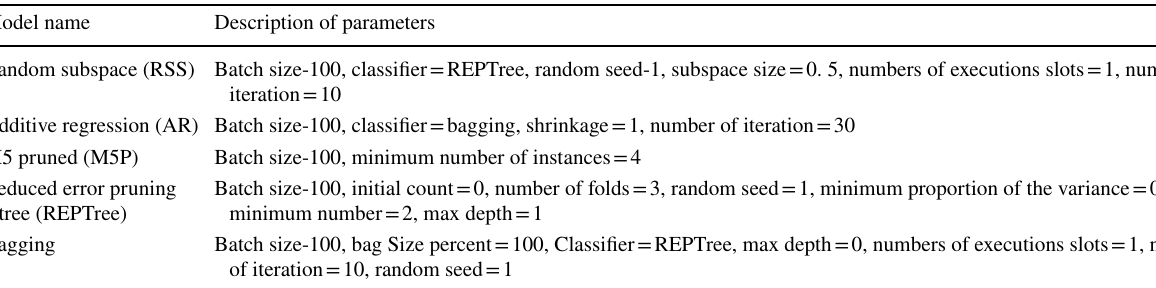
Table 3 Inputs selection using regression analysis for modeling PE at Baghdad station No. of Variables variables